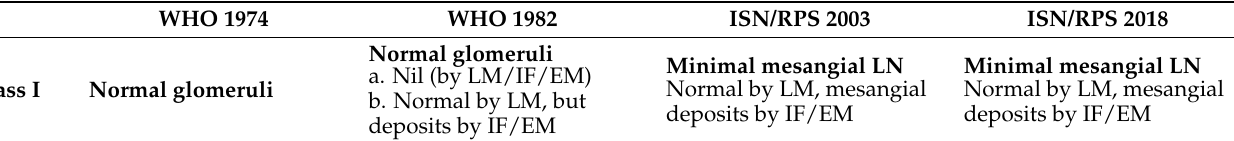
Table 3. The evolution of LN classifications (adapted after